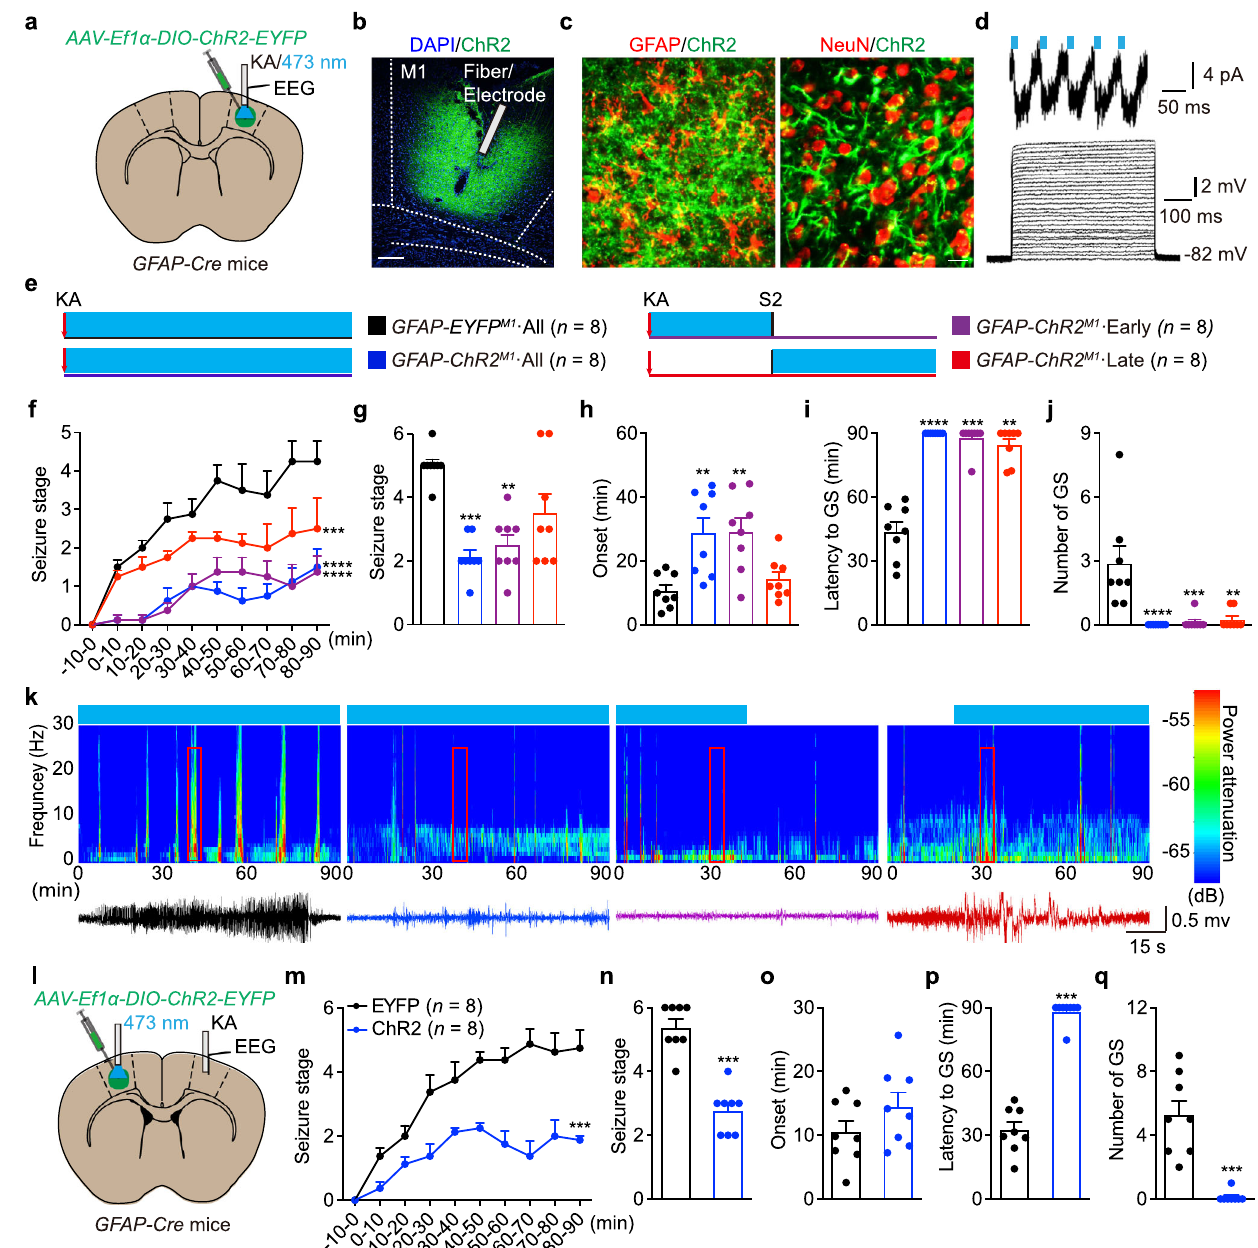
Fig. 1 | Optogenetic stimulation of ChR2-expressing astrocytes attenuates KA-induced neocortical seizures. a Schematic of viral injection, stimulation and EEG recording in GFAP-ChR2 M1 mice. b Fluorescent image showed restricted expression of ChR2-EYFP in M1. Scale bar, 200 μ m. c Left, fl uorescent image of ChR2 (green) showed co-localization with GFAP + astrocytes (red). Right, fl uor- escentimageofChR2(green)showednoco-localizationwithNeuN + neurons(red). Scale bar, 20 μ m. d Light pulses induced inward currents in ChR2-expressing astrocyte in a cortical slice. Voltage responses from a ChR2-expressing astrocyte evoked by 10-pA step current from 0 to 300pA. e Paradigms of blue light stimu- lation in different phases of KA-induced seizures. f Effects of optogenetic stimu- lation of astrocytes on the development of seizure stage during 90min after KA injection. g – j Effects of different-phase optogenetic stimulation of astrocytes on